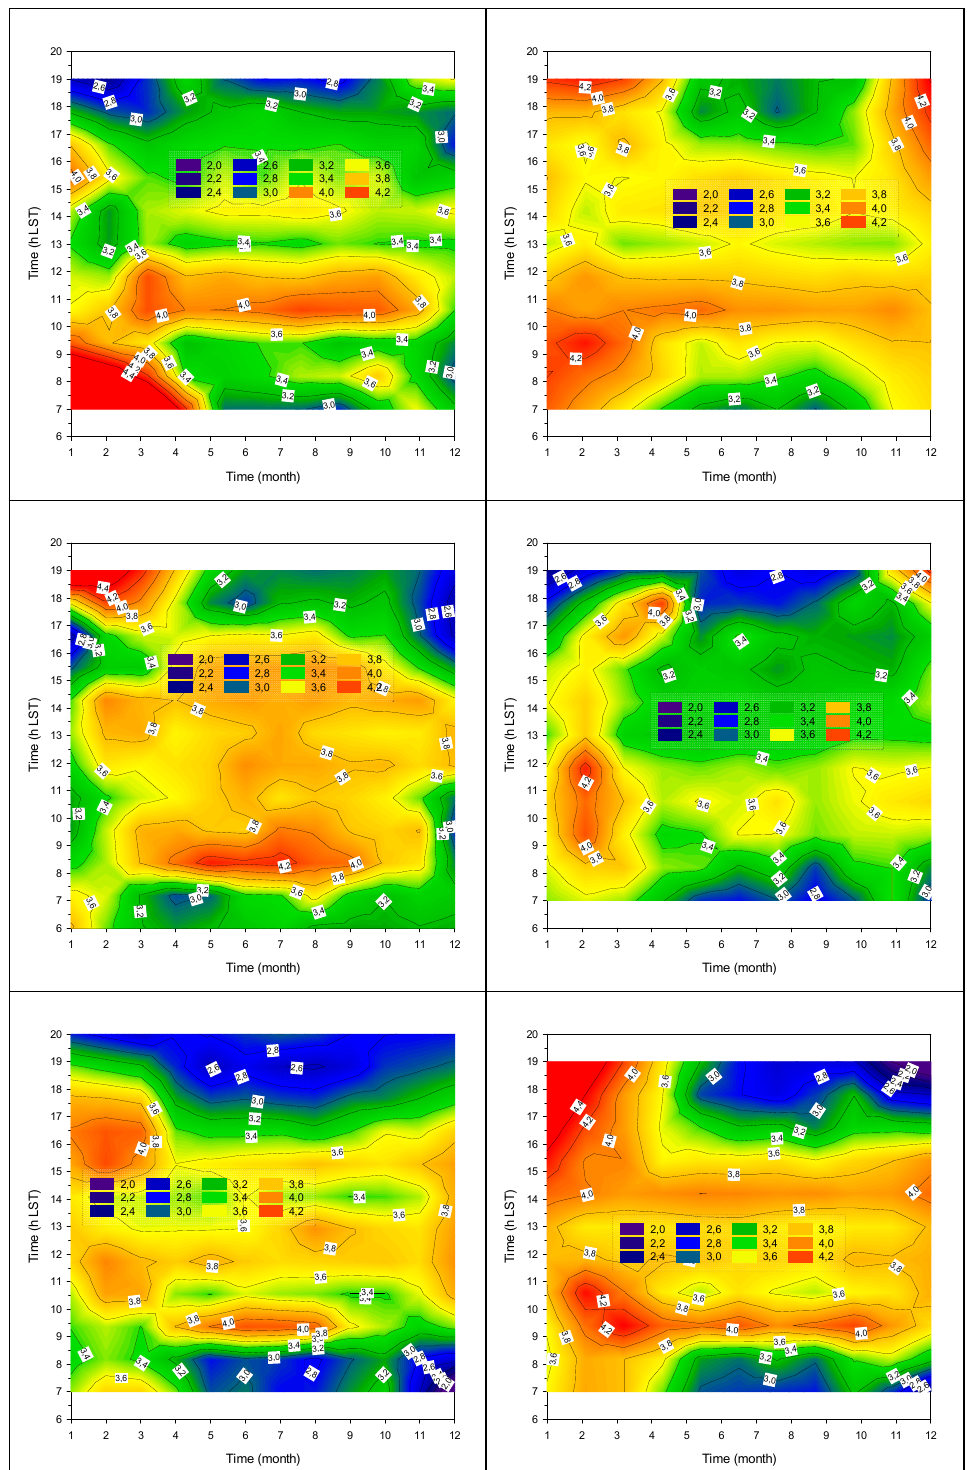
Figure 6. Month–hour diagrams of the T L values in TATY under clear-sky conditions in climatic zone A: first raw, Irakleio (left), Kalamata (right); climatic zone B: second raw, Agrinio (left), Lesvos (right); climatic zone C: third raw, Alexandroupoli (left), Tripoli (right); climatic zone D: fourth raw: Kastoria (left), Serres (right). The color code refers to the T L levels, which have been kept in the range 2 ≤ T L ≤ 4.2. The 06.00–20.00 h LST interval limitation of the graphs is due to the adopted criterion γ ≥ 5°.